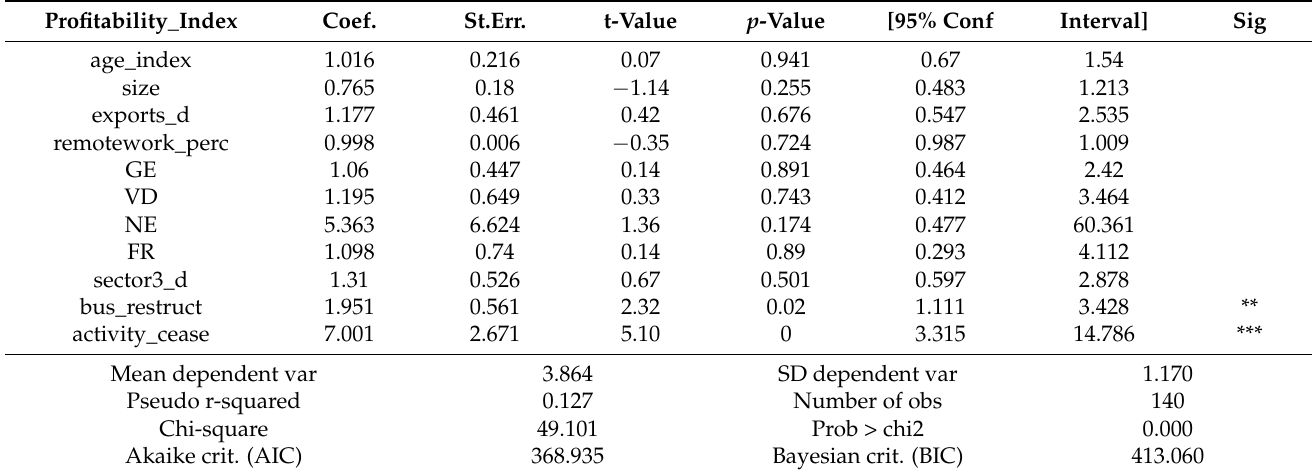
Table 9. Ordinary logit model results with profitability index—Odds